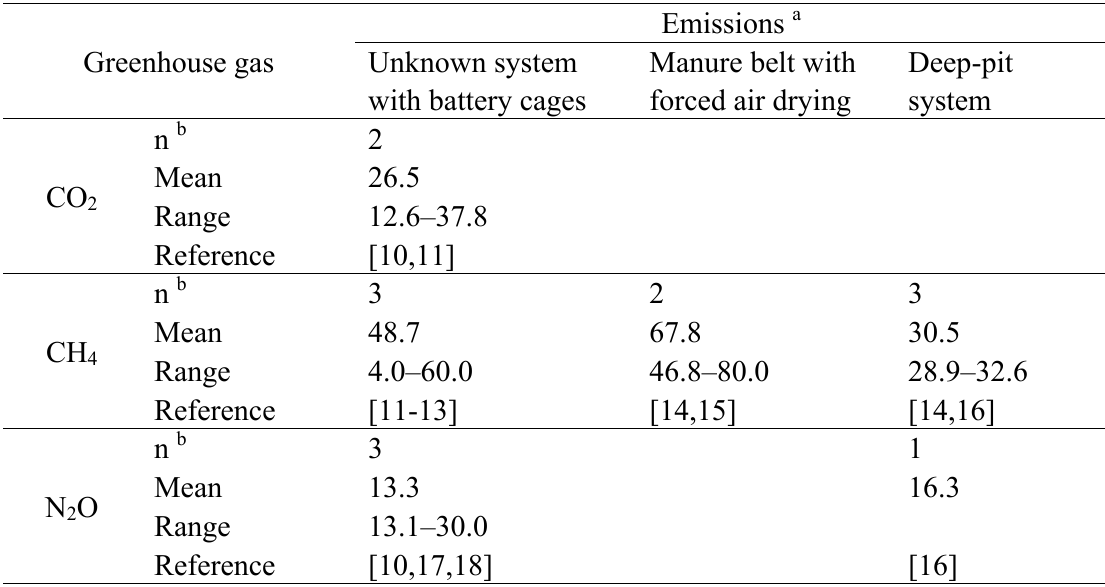
Table 1. Carbon dioxide (kg yr − 1 hen − 1 ), methane (g yr − 1 hen − 1 ) and nitrous oxide (g yr − 1 hen − 1 ) emissions from cage layer